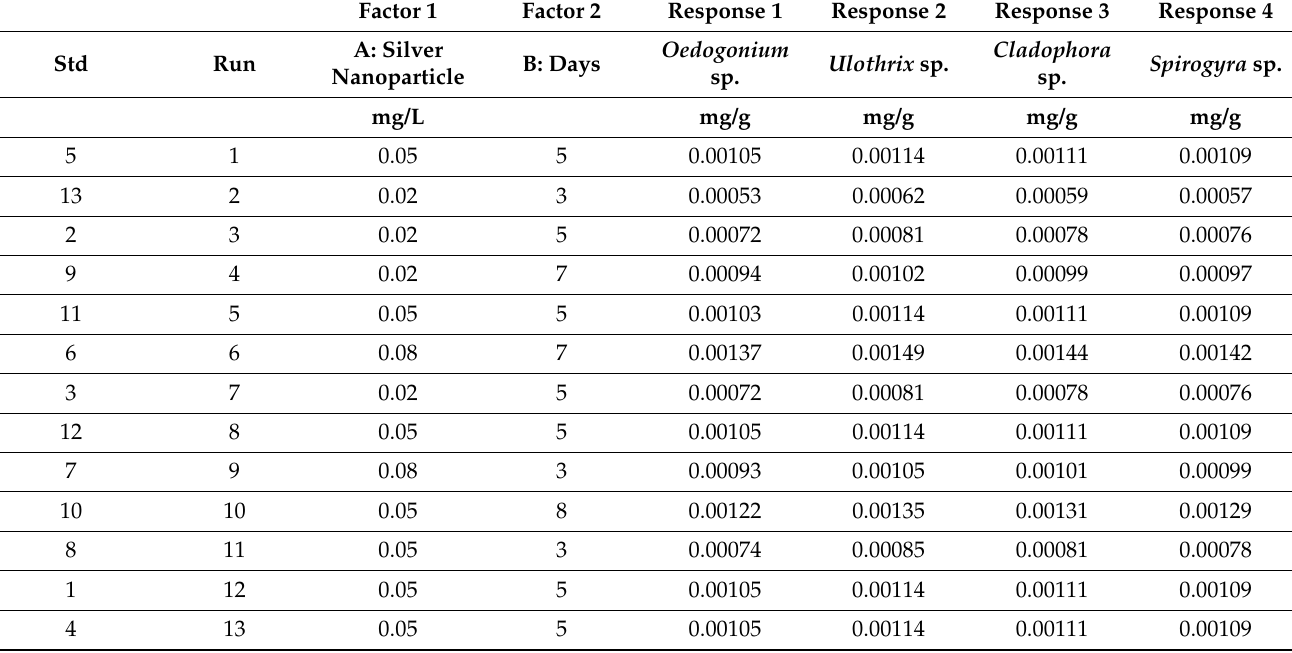
Table 1. Central composite design results from silver ion uptake by